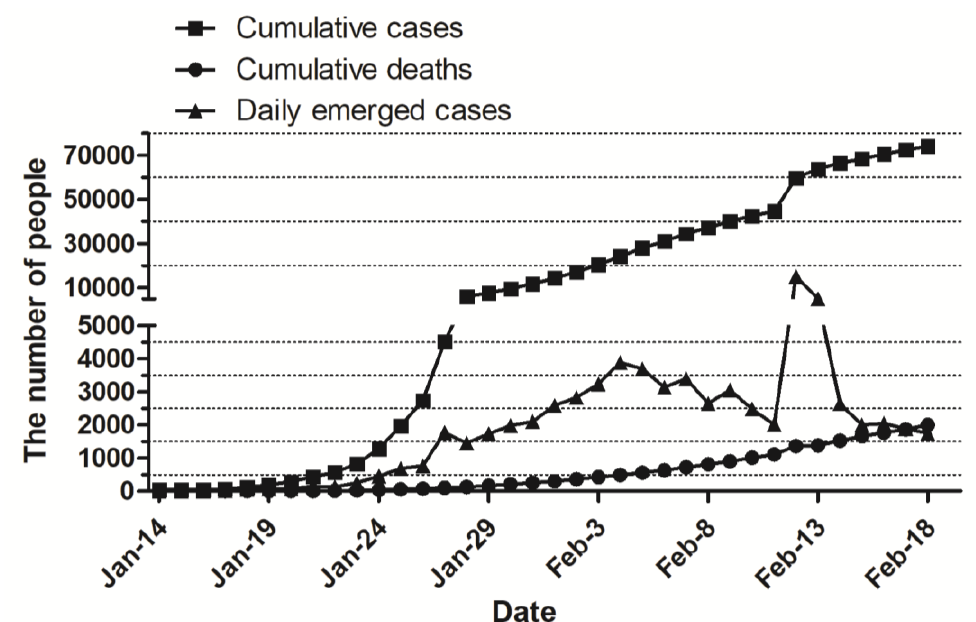
Figure 1. Daily cumulative / emerged number of confirmed cases and fatal cases of Coronavirus Disease 2019 (COVID-19) in Mainland China. As of 18 February 2020, the total number of confirmed cases and deaths reached 74,185 and 2004, respectively. Since 16 February 2020, the total number of confirmed cases increased quickly; the daily emerging cases increased steadily to 3886 on February 4, and then fluctuated to 2015 on 11 February 2020; the fatality cases number increased slowly to 2004 cases on 18 February 2020. The cumulative and daily emerged cases number jumped to 59,804 and 15,152, respectively, on 12 February 2020.